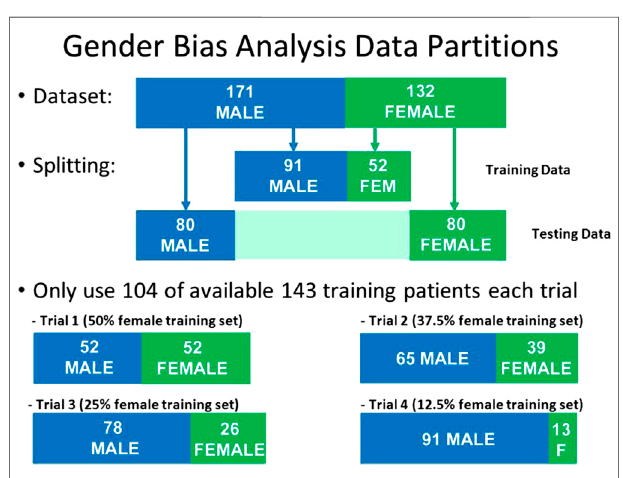
FIGURE5| DatapartitionsusedforGenderBiasanalysis.Thesizeofthe test set and the size of the training set were kept constant, but the proportion of males and females was varied in the training